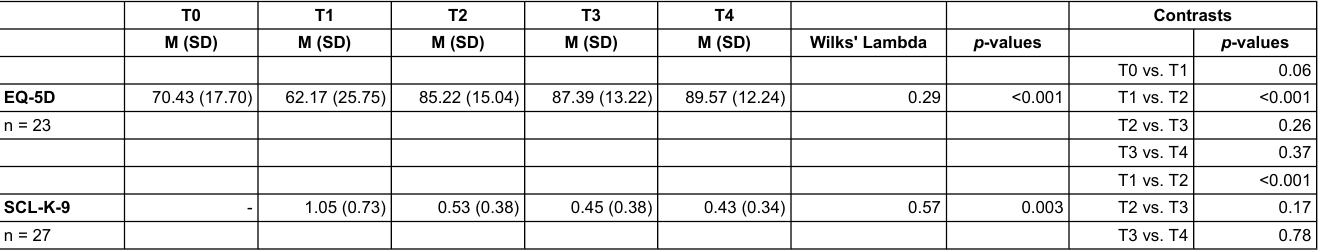
Table 2: Pre- and post-transplant quality of life and psychological distress in lung transplant